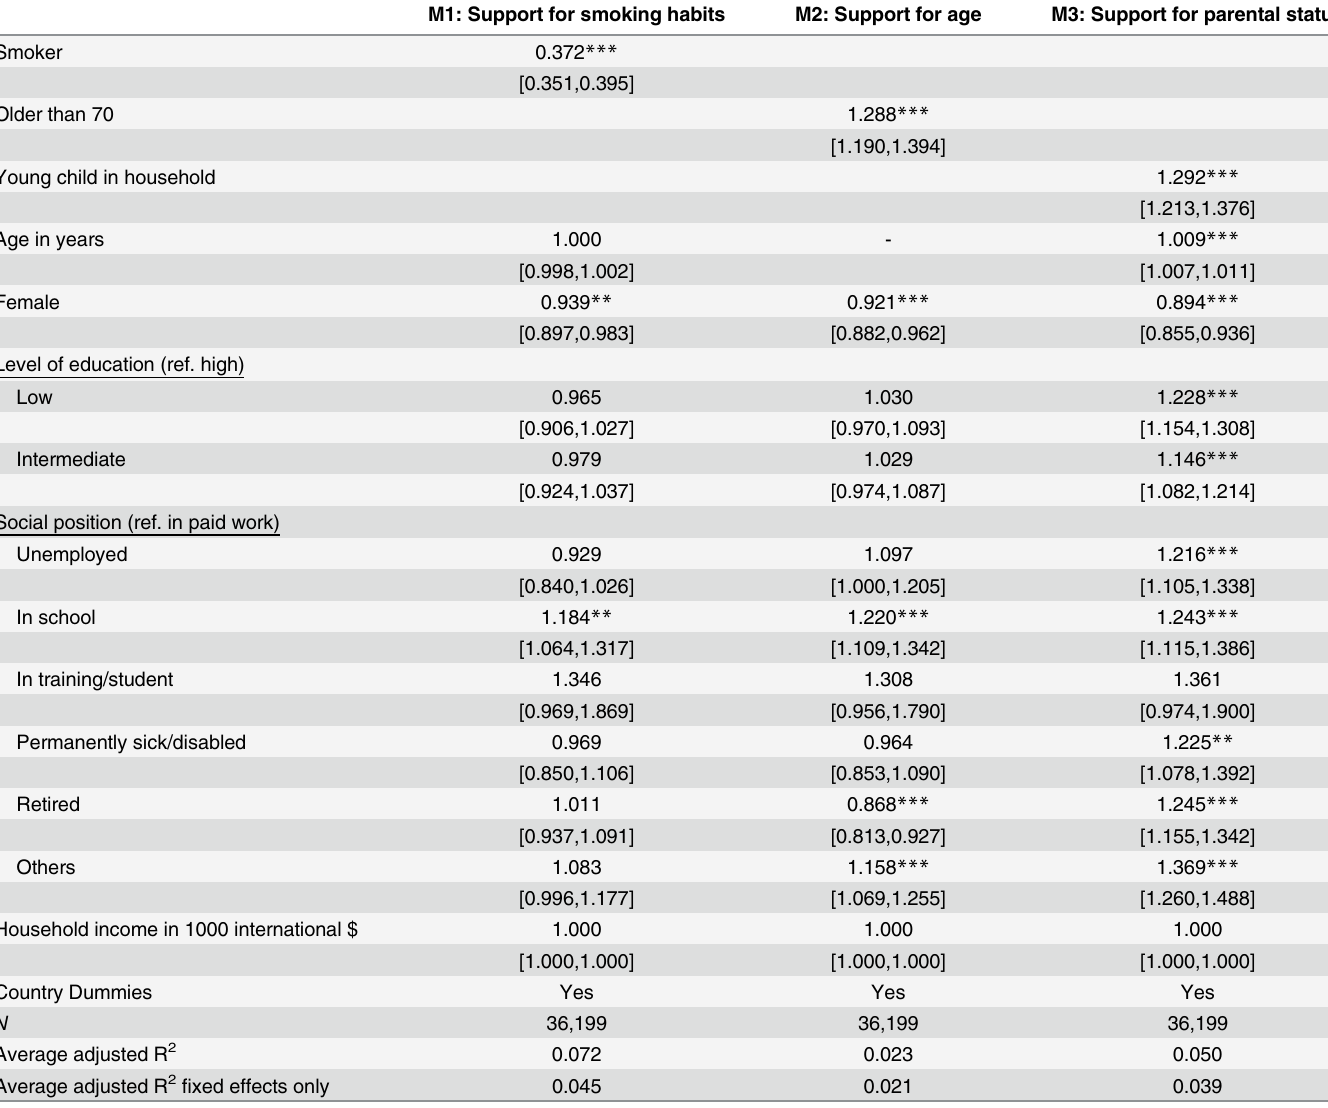
Table 3. Fixed-Effect logistic regression models: influencing factors on peoples ’ support of smoking habits, age and parental status as priority criteria. M1: Support for smoking